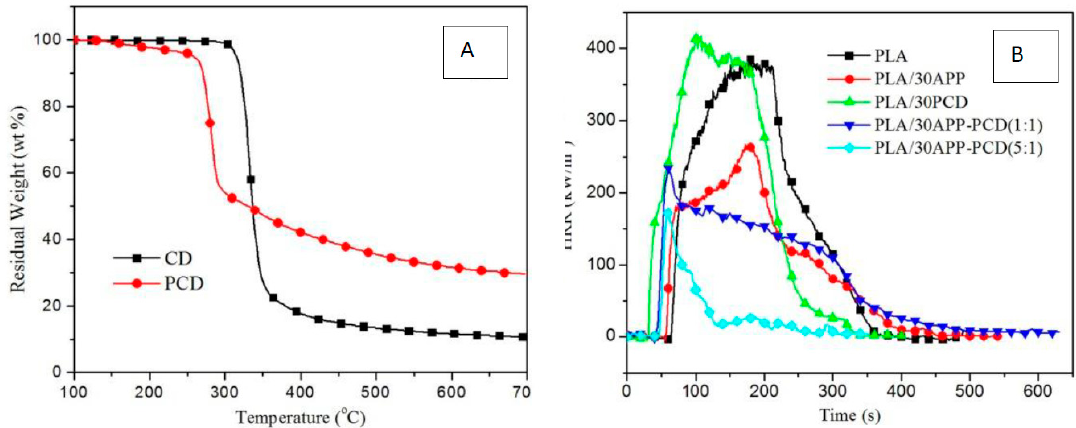
Figure 4. TGA of BCD (CD), and of phosphorylated BCD (PCD) (nitrogen flow, heating rate 20 ◦ C/min); ( A ) Heat release rate in cone calorimeter test for PLA with 30% of various PCD/APP FR mixturesAPP/PCD in different ratio, (1:1 and 5:1); ( B ). Adapted with permission from ref. [58].